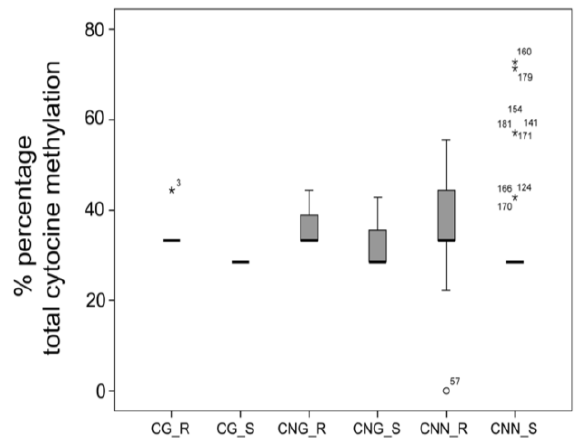
Figure 3. Total cytosine methylation changes for the CG, CNG, and CNN islands of the genomic sequence of the EPSP-synthase 1 gene for the S and R populations. Each boxplot represents the percentage of 5′-Me-C at each island, respectively. * represents extreme values more than 3.5× of the interquartile range of the box which contains the middle 50% of the records, ° represents extreme values more than 1.5× of the interquartile range of the box.